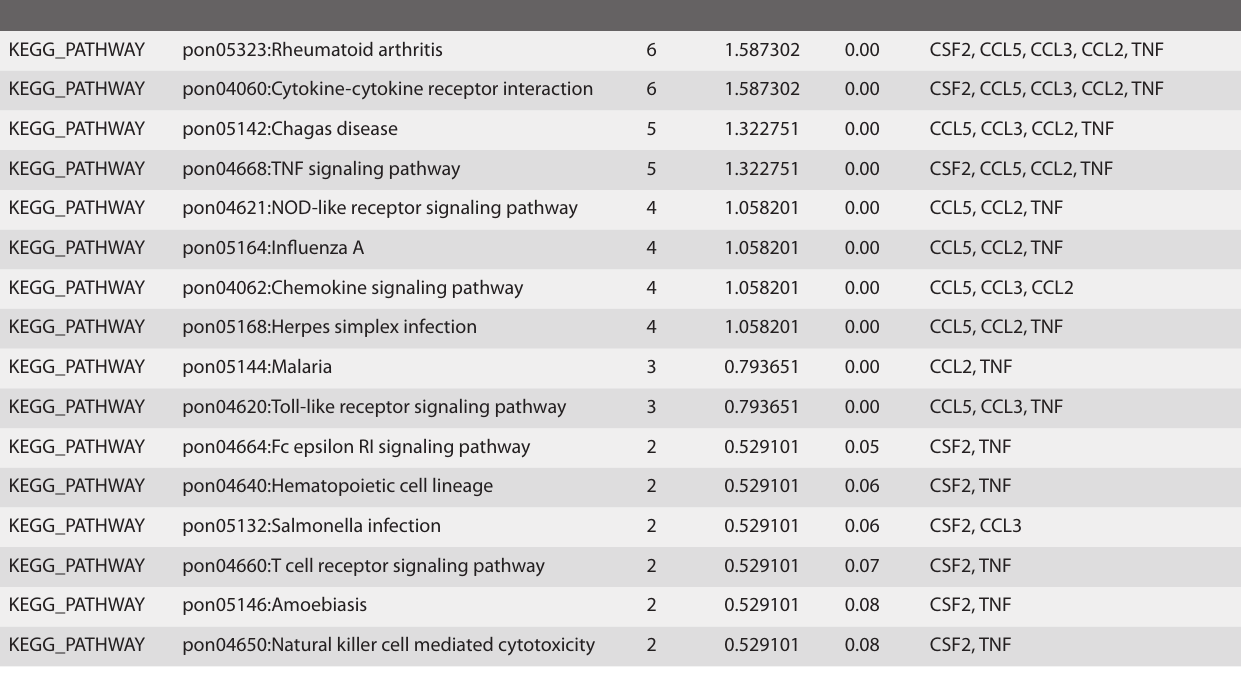
Table 3. Pathway analysis of differential expressed genes between allergic rhinitis and healthy PNECs.